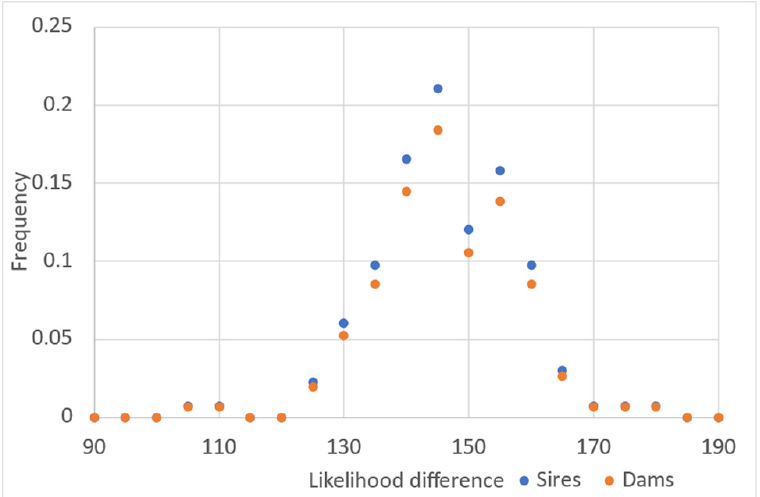
Figure 2. Histogram of the likelihood difference between the chosen candidate (sires or dams) and unrelated sires or dams for each progeny evaluated using all markers included in the panel (272 SNPs).